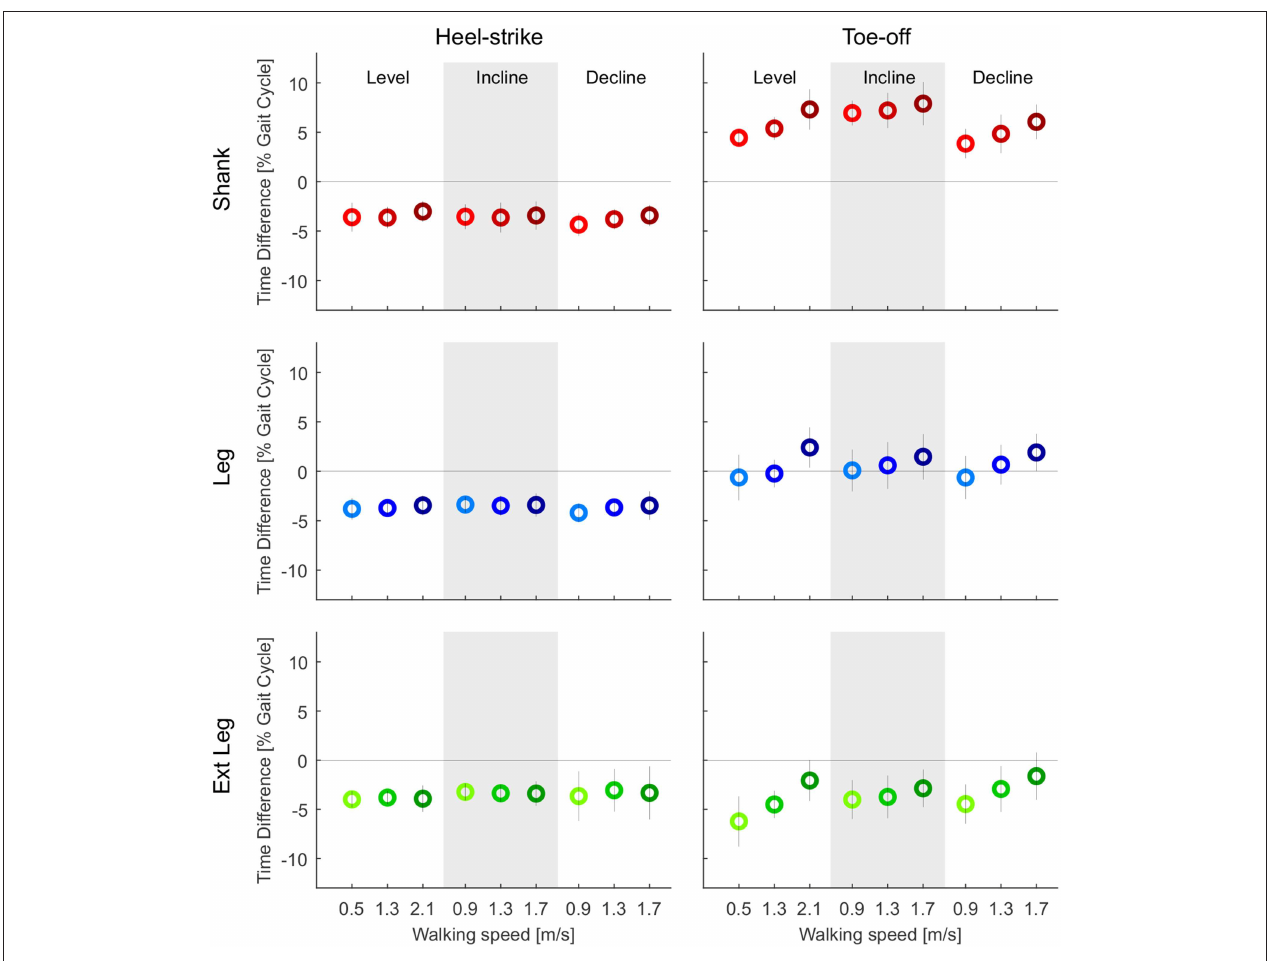
FIGURE 8 | Time difference of the mean zero crossings of the angular velocity based on the optical motion capture data to the heel-strike (left) and the toe-off (right) identified by ground reaction forces (GRF). Evaluated segment angular velocities from the thigh (orange), shank (red), leg (blue), and extended leg (green). Distances are evaluated for three different speeds of level walking, walking inclines, and walking declines. Darker colors indicate greater speeds (0.9, 1.3, and 1.7m/s for slopes, and 0.5, 1.3, and 2.1m/s for level walking). The standard deviation is indicated by the vertical line. The specific detection rule sets, that were designed for the IMU data, were also applied to the Motion capture data to only detect one transition for each event. Positive and negative values indicate zero crossings after and before, respectively, the GRF based event